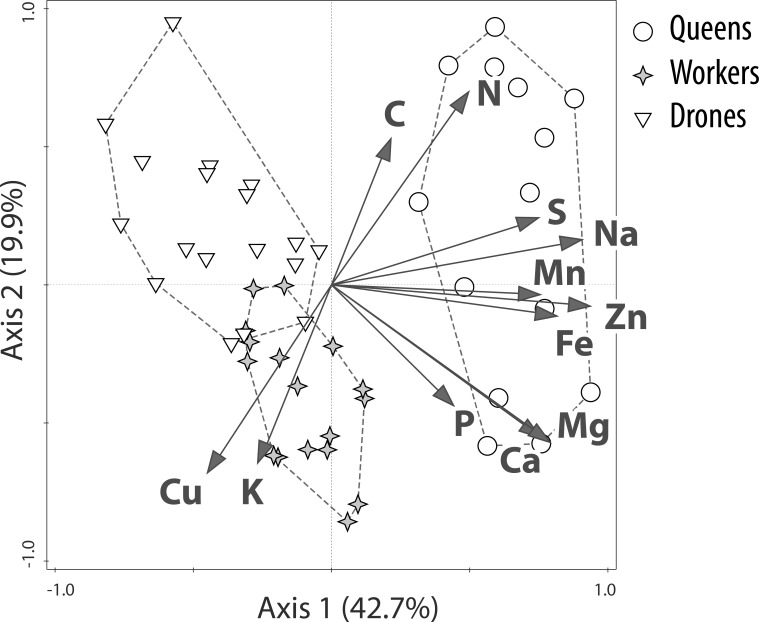
PCA plot—Multivariate analysis of stoichiometric relations in honeybee castes and sexes.The first two axes are presented. Queens are separated from the other castes/sexes primarily due to their relatively high concentrations of Zn, Na, Fe, Mg, Ca, Mn and S. Drones form a cluster separate from all females mainly due to the males’ relatively high concentrations of C and N and low concentrations of P, Ca, Mg and Zn. These tendencies were confirmed by ANOVA computed independently for the 1st and 2nd axis scores (p<0.05).